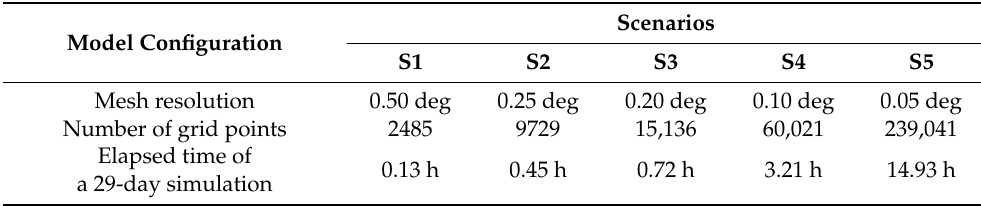
Table 1. The number of grid points and elapsed time of a 29-day simulation for different mesh resolutions used in the numerical